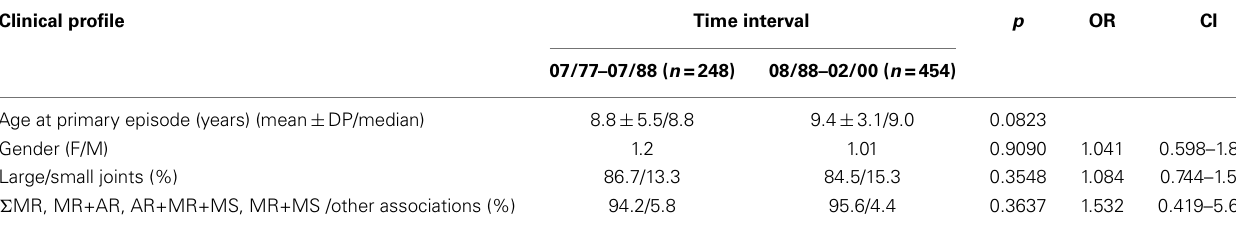
Table 3 | Comparative analysis of the clinical profile of presentation .